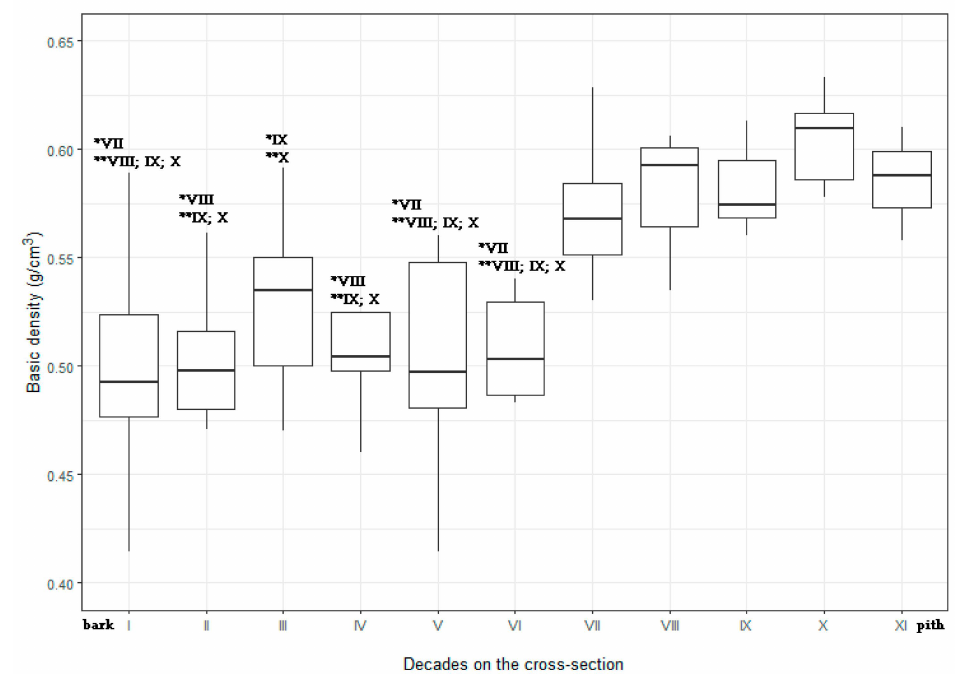
Figure 2. Distribution of basic density (g/cm 3 ) on the cross-section of the trunk from bark (section I) to the pith (sections X/XI) with marked * significant and ** highly significant differences between wood samples using Tukey’s HSD test. Whiskers corresponding to minimum and maximum values, boxes represent the 1st and 3rd quartile values, midlines indicate the median.